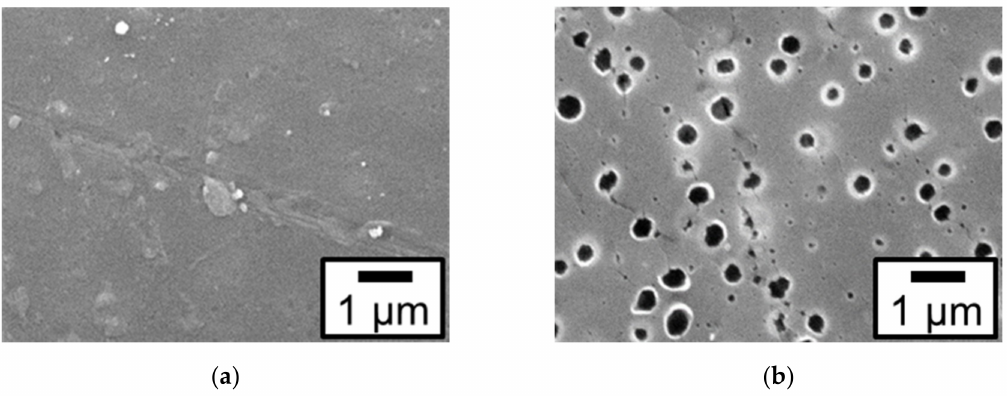
Figure 1. Scanning electron microscope (SEM) images of the surface of the acrylonitrile–butadiene–styrene copolymer (ABS) substrate not containing Pt particles before and after etching: ( a ) ABS-untreated and ( b ) ABS-Etch.